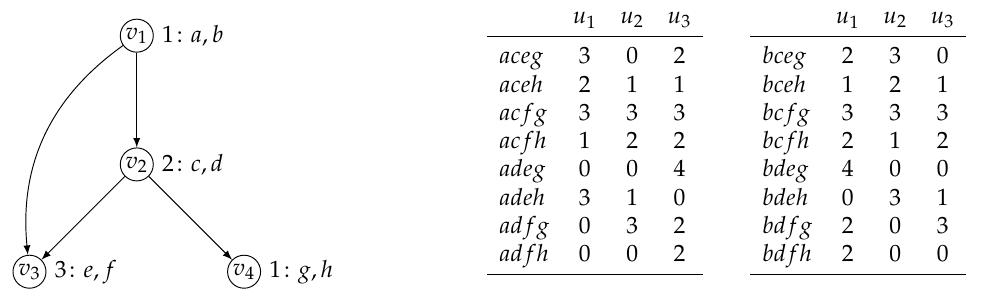
Figure 4. The Boolean circuit C f 14 value of x 0 represents the choice for a or b at v 1 , the value of x 1 the choice for c or d at v 2 , and the value of y 0 the choice for e or f at v 3 . The local indices of a , c , and e are given by 0, and those of b , d , and f by 1. The instantiation on the right thus represents that f 14 v